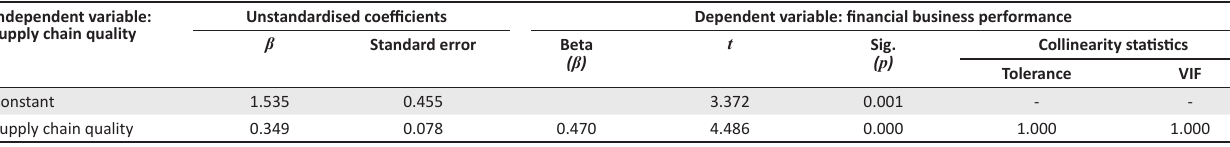
TABLE 9: Regression model 3: Supply chain quality and financial business performance. Independent variable: supply chain